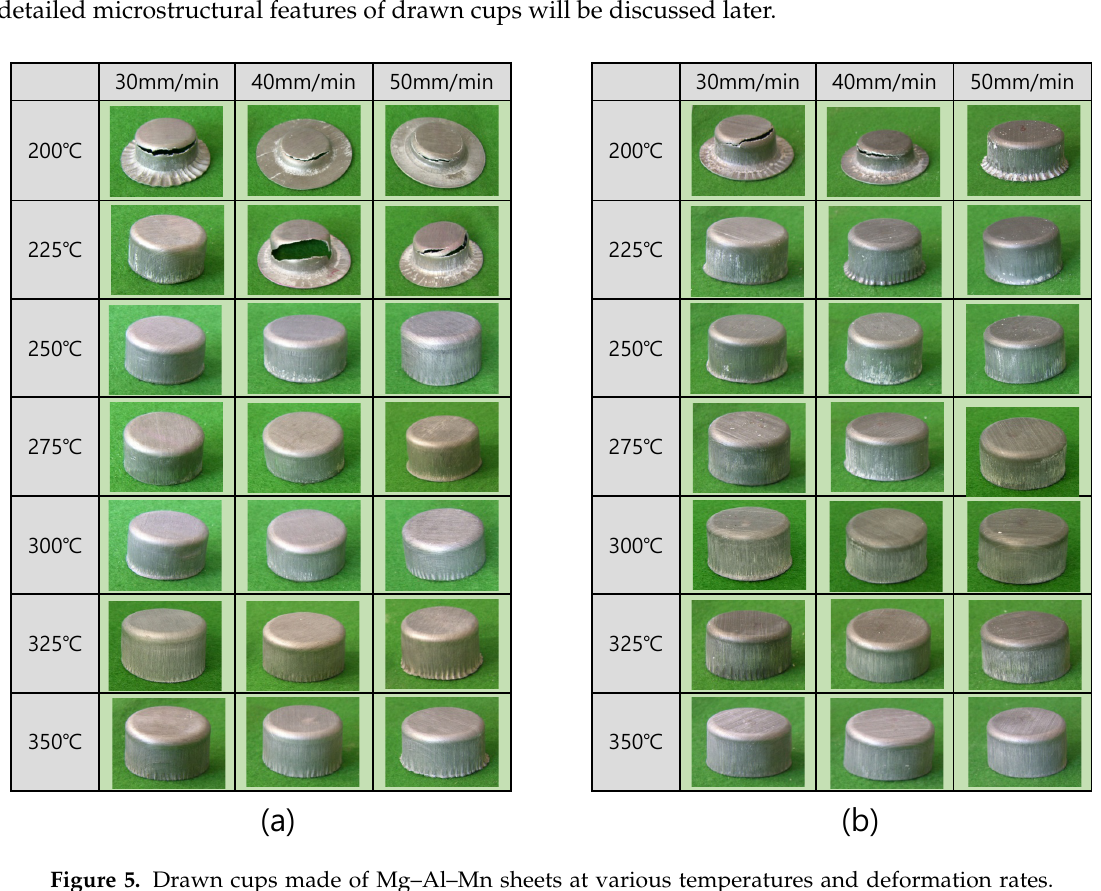
Figure 5. Drawn cups made of Mg–Al–Mn sheets at various temperatures and deformation rates. ( a ) TRC, ( b )